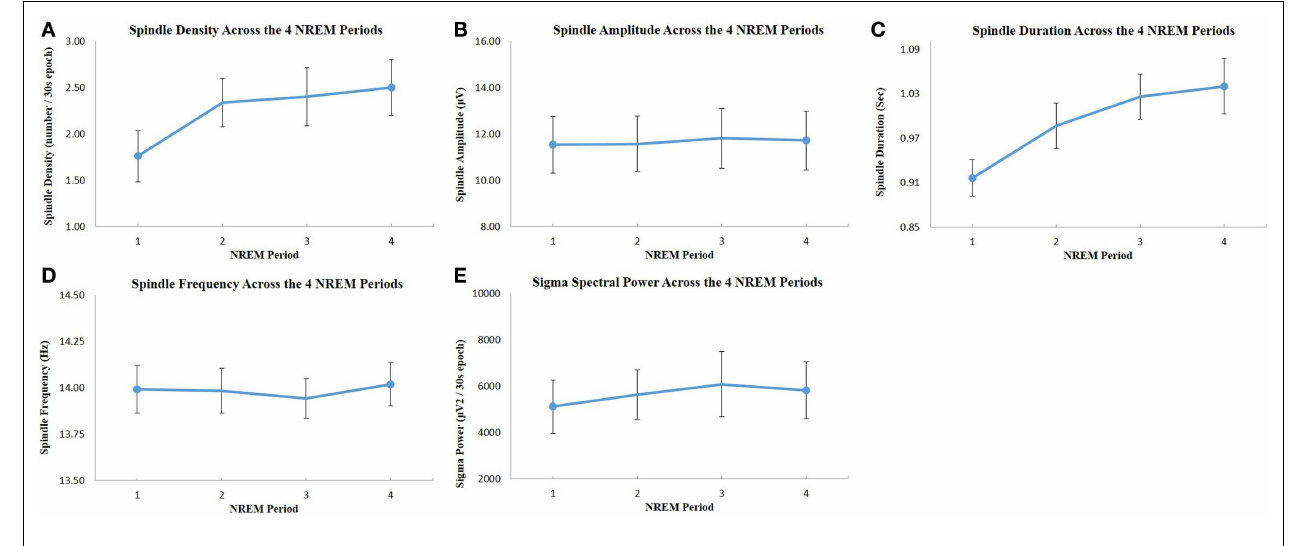
FIGURE 2 | Evolution of spindle parameters and sigma power across the four NREM sleep periods: (A) spindle density; (B) spindle maximum amplitude; (C) spindle duration; (D) spindle frequency; (E) EEG spectral power in the sigma frequency band . All values were extracted from C4–O2 EEG derivation.The dots represent the mean value,